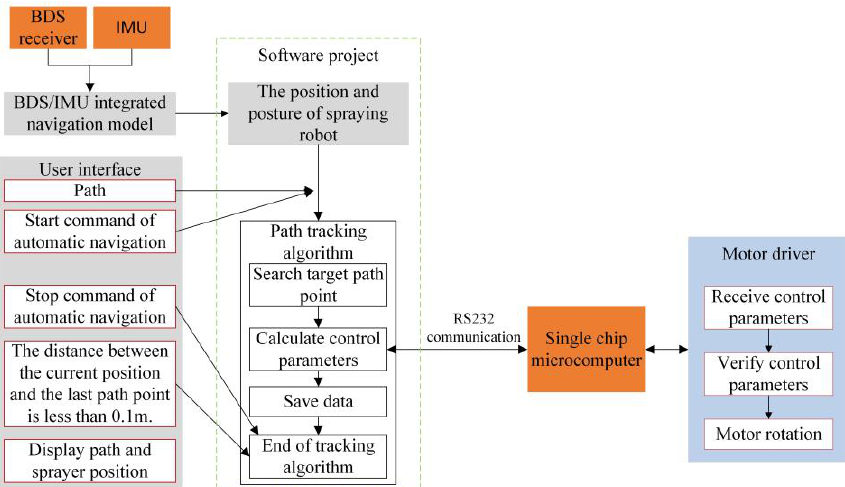
Figure 6. The structure of the path tracking system.